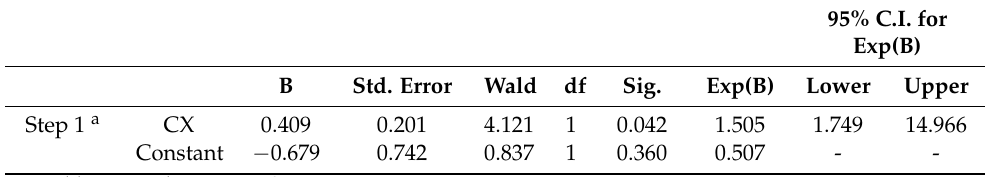
Table 14. Technology complexity: regression analysis for PaaS.